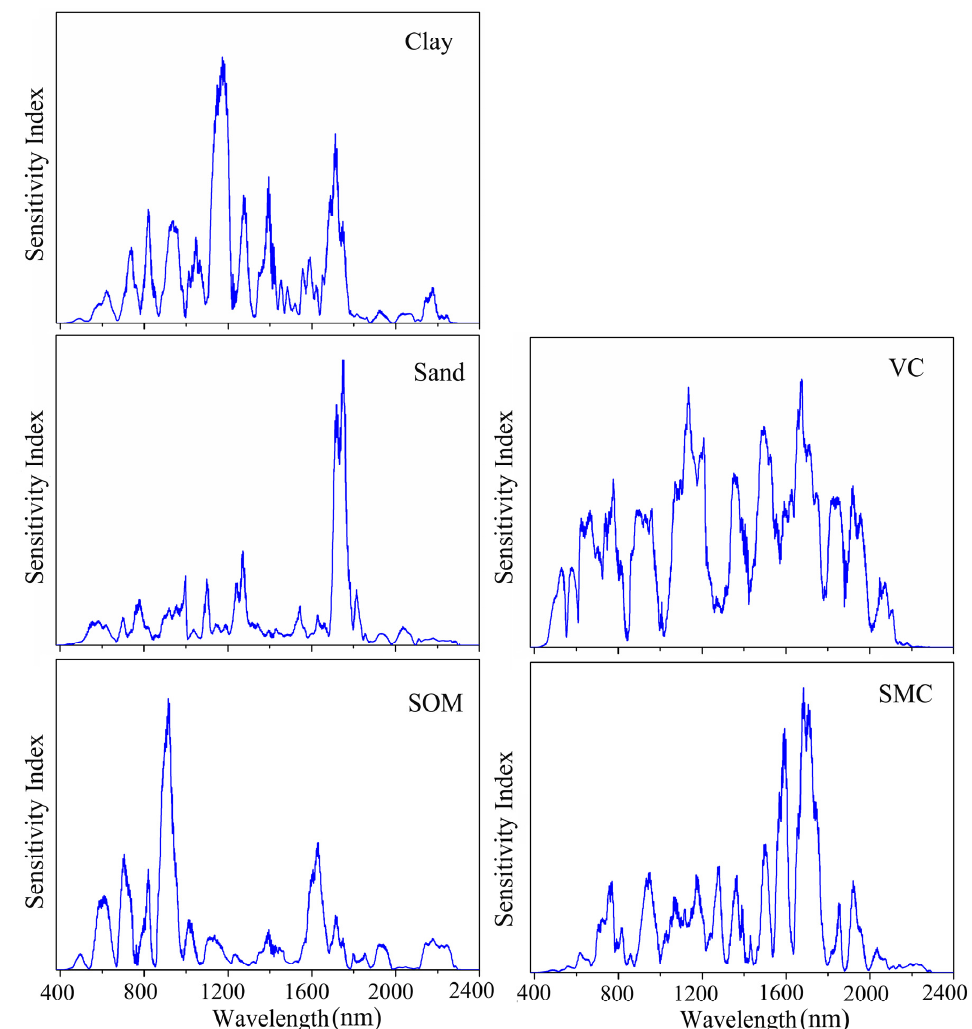
Figure 8. The important wavelengths used by the one-dimensional convolutional neural network (1DCNN) model to predict soil properties and vegetation coverage